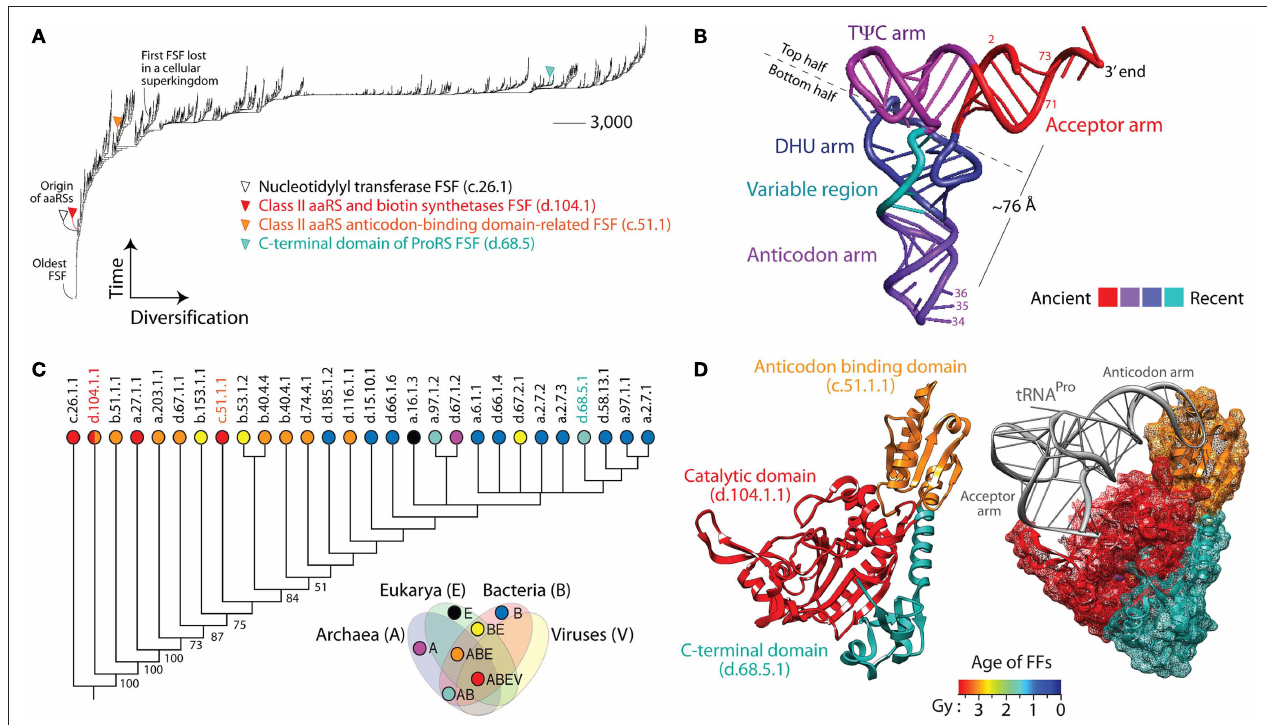
Figure 1 | Trees of domains (ToDs), trNAs, and aminoacyl-trNA synthetase (aarS) history. (A) ToD reconstructed from a genomic census of protein domain structures at fold superfamily (FSF) level of SCOP in 1,037 cellular organisms and viruses (Nasir et al., 2012). Taxa are FSFs and characters are proteomes. While leafs are not labeled with names of FSFs as these would not be legible, FSFs linked to selected domains of aaRS enzymes are identified. (B) tRNA molecule with arms colored according to their age (Sun and Caetano-Anollés, 2008). The most important identity determinants recognized by aaRSs are located in the anticodon loop of the anticodon arm and in the acceptor stem (labeled with nucleotide numbers), which are separated in space by ∼ 76 Å. (C) ToD describing the evolution of 28 domain families of aaRSs in 1,037 cellular organisms and viruses. Taxa are aaRSs fold families (FFs) and characters are proteomes. Numbers on the branches indicate bootstrap support values and taxa are labeled with SCOP concise classification strings with corresponding circles colored according to the distribution of families in cellular